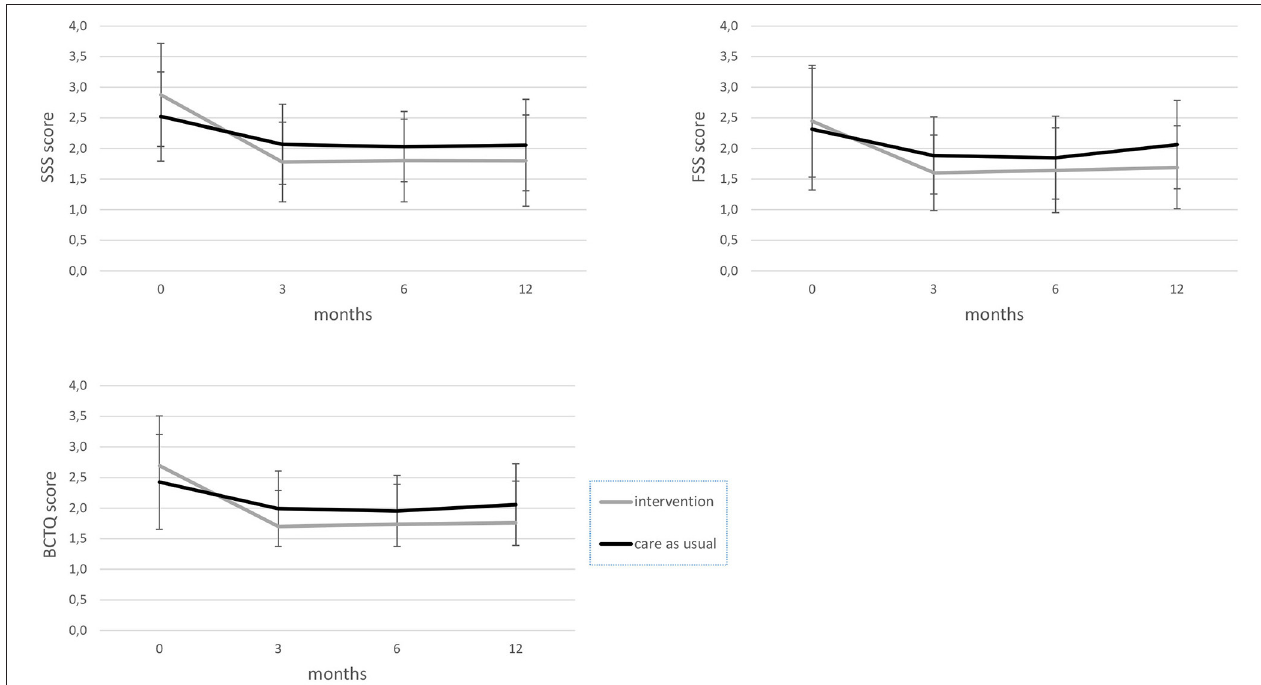
FIGURE 1 | BCTQ, FSS, and SSS scores from baseline to the 12-month follow-up for the intervention and care-as-usual groups, excluding participants who had surgery. BCTQ, boston carpal tunnel questionnaire; FSS, functional status scale; SSS, symptom severity scale.